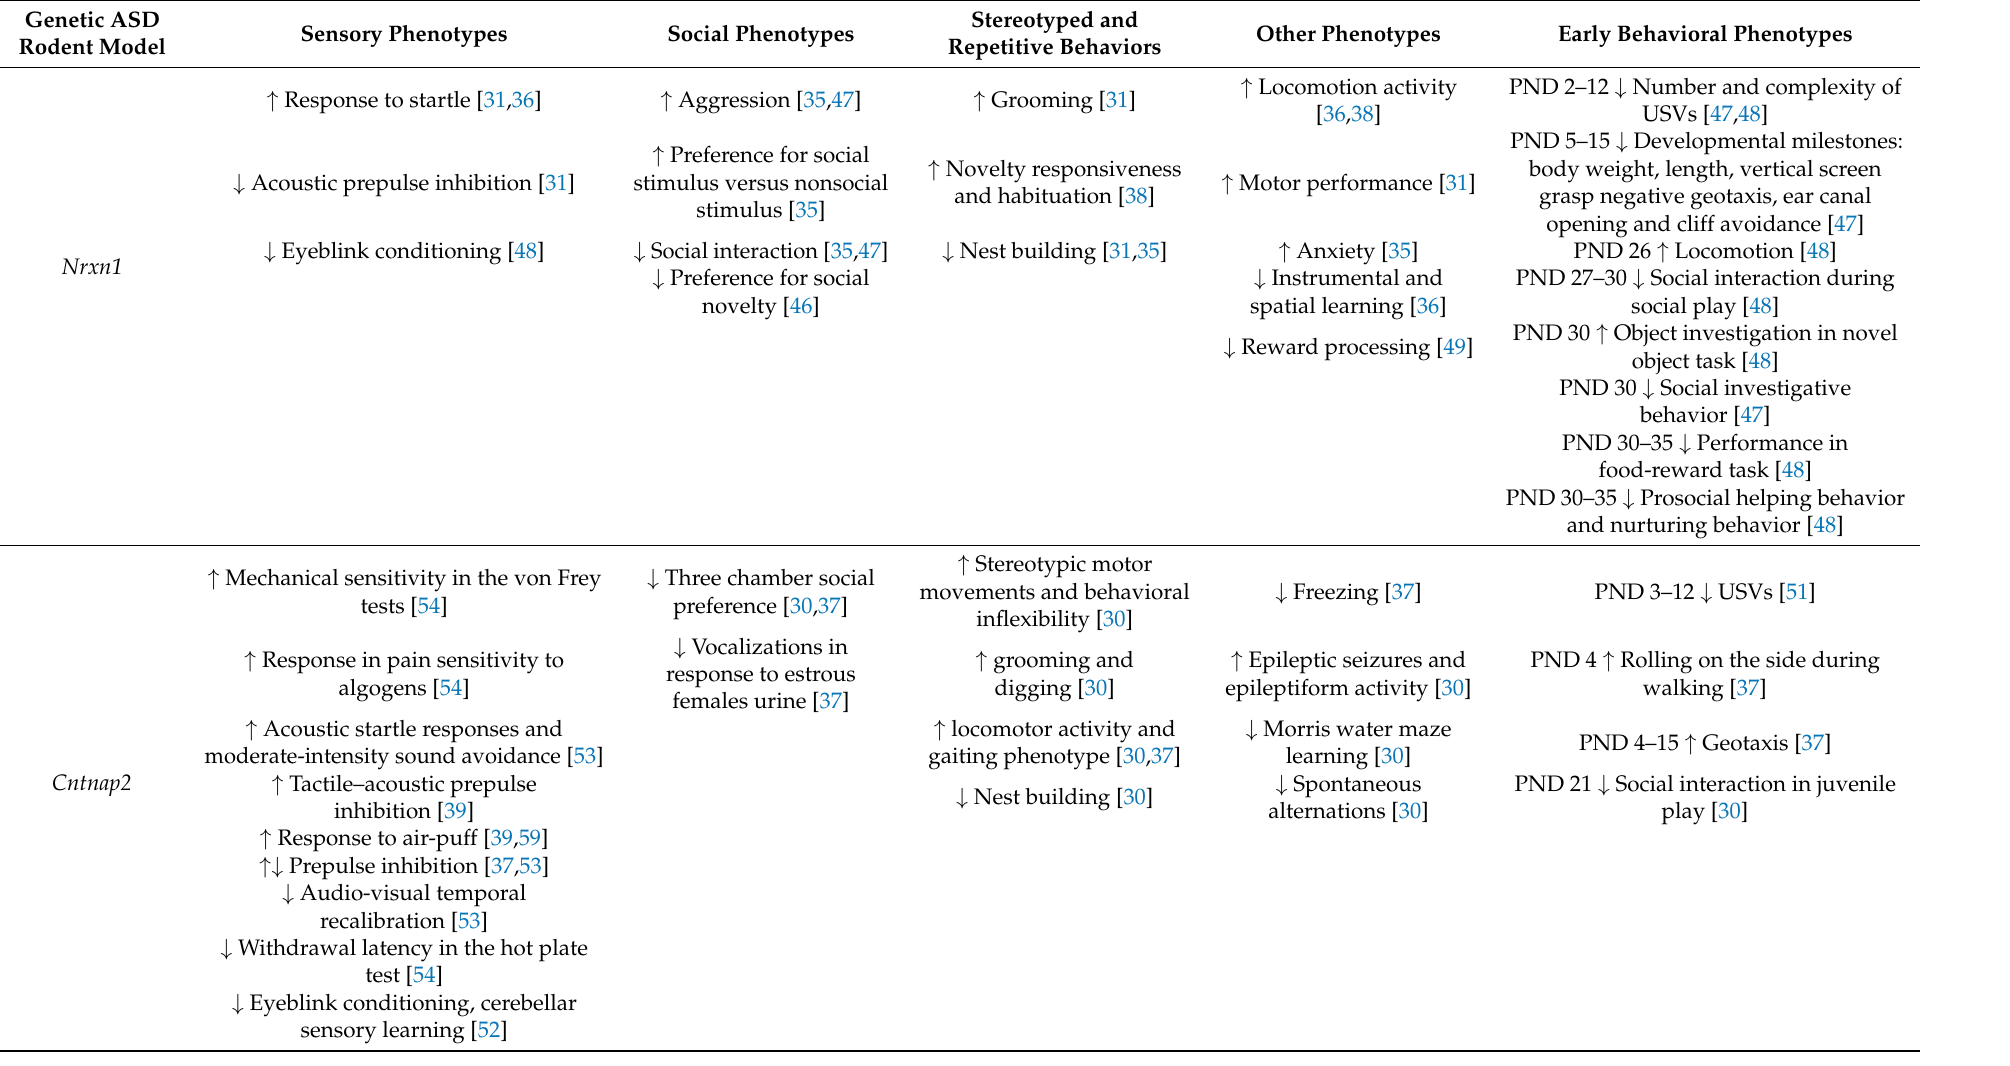
Table 1. Overview of behavioral phenotypes in the Nrxn1 , Cntnap2 , and Shank3 rodent models of synaptic dysfunction in